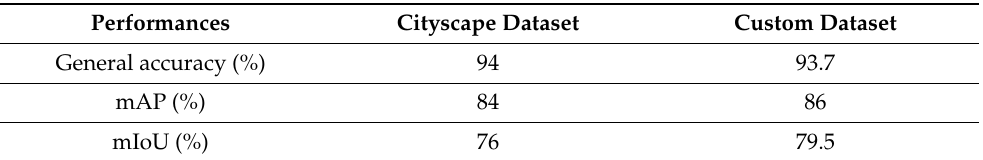
Figure 4. Segmentation of validation images. Table 3. Precision (mAP) and IoU of FC-HarDNet trained on Cityscape and on our personalized dataset.